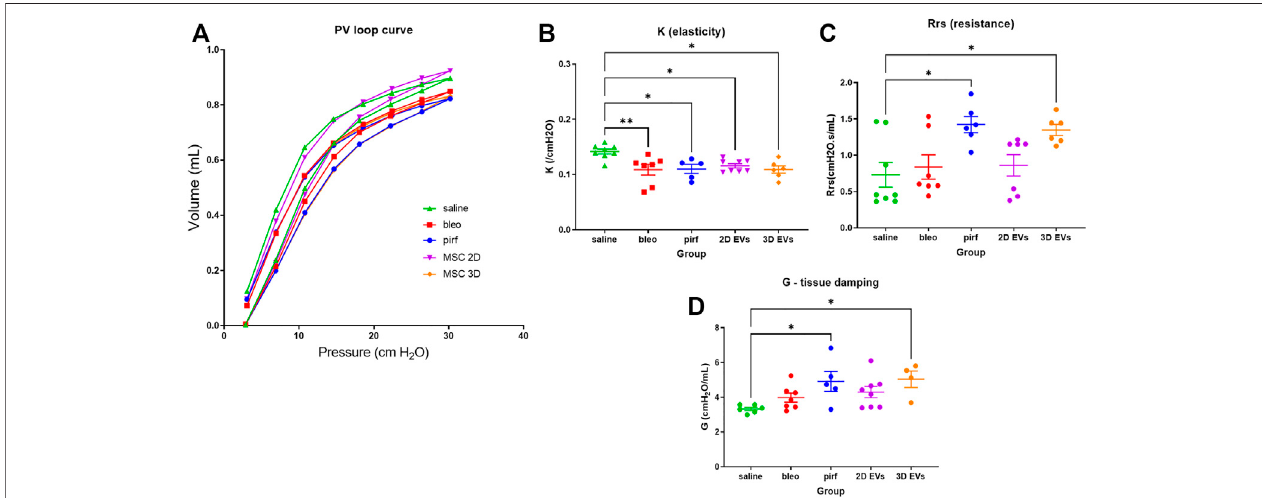
FIGURE 5 | Lung function data in bleomycin-challenged aged mice performed at D28. (A) Dynamic PV loop curve of mouse lungs generated from volume-driven PV loops. (B) Coef fi cient of elasticity, K, determined by the Salazar-Knowles equation. (C) Dynamic resistance of the respiratory system, Rrs, obtained from single- frequencyoscillation technique. (D) Lungtissue damping,G,assessed frombroadbandfrequencyoscillation technique.Alldataareshownasmean ±SEM, n =5-8per experimental group; each symbol represents 1 animal, one-way ANOVA followed by Tukey ’ s post hoc test for multiple comparisons, * p < 0.05, ** p < 0.01.